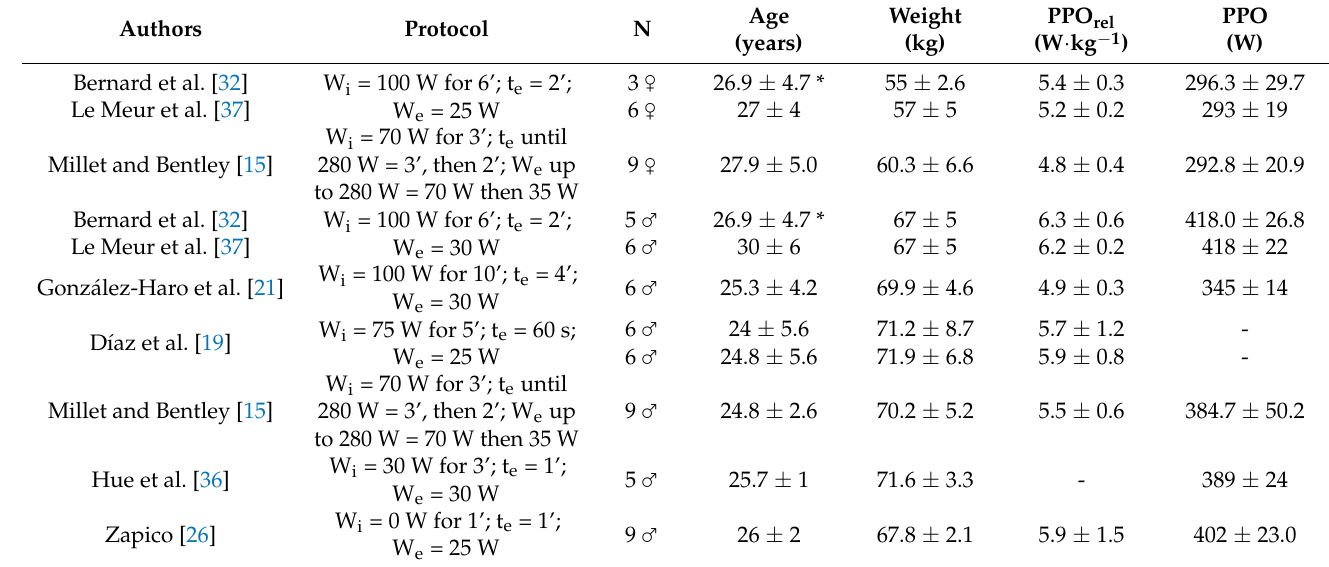
Table 7. Mean ± SD of peak power output (PPO) in cycle ergometer tests of elite triathletes.